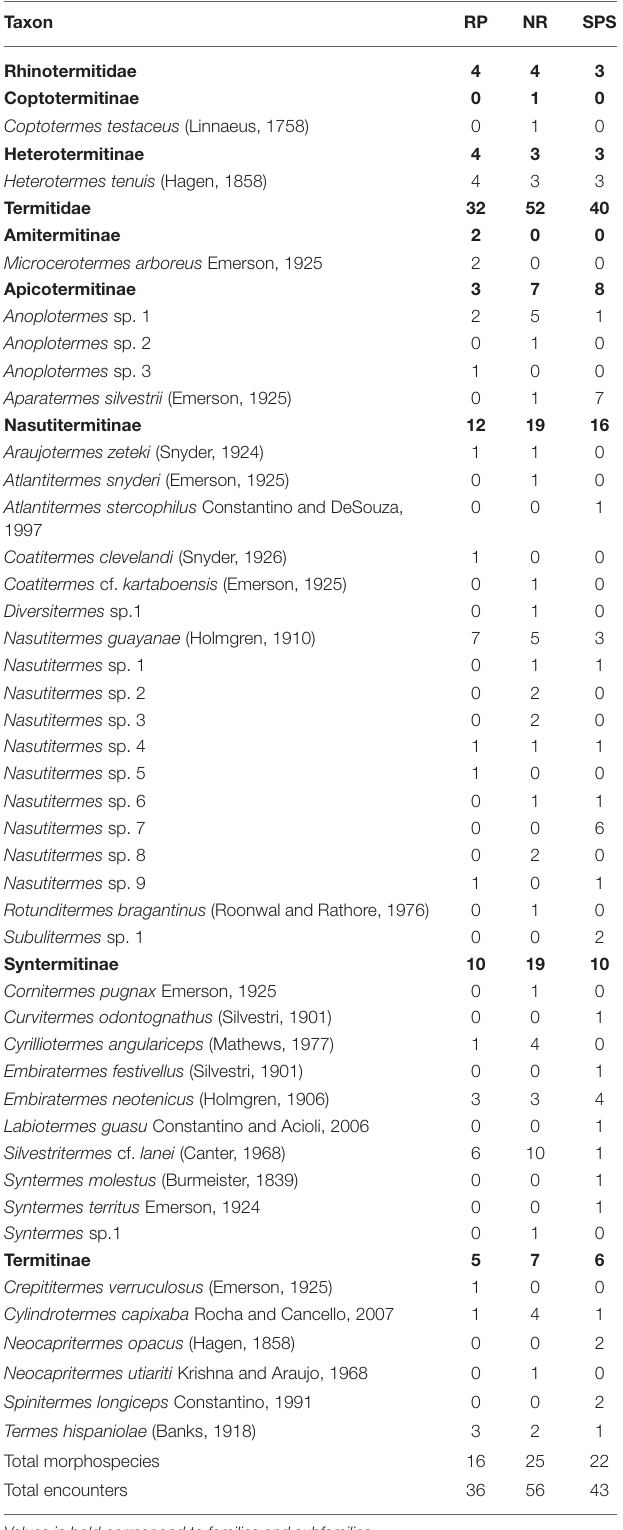
TABLE 3 | Termite species encounters per transect (or morpho-species) at individual sampling points, in Natural Regeneration (RN), silvopastoral systems (SPS), rubber plantations (RP) in Colombian Amazon